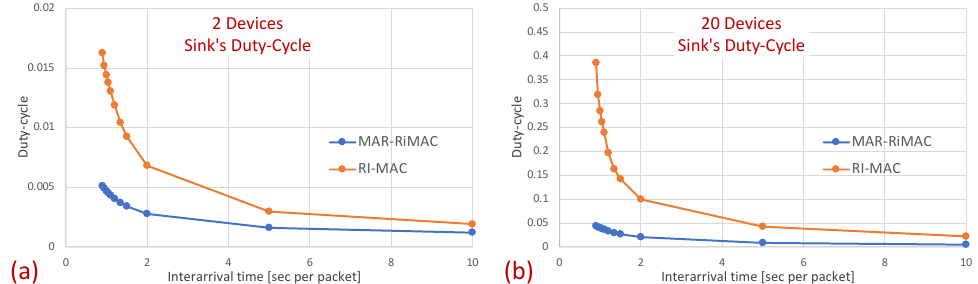
Figure 9. Clique topology: The sink’s mean duty cycle for different numbers of devices and K = 4. ( a ) Two devices. ( b ) Twenty devices.